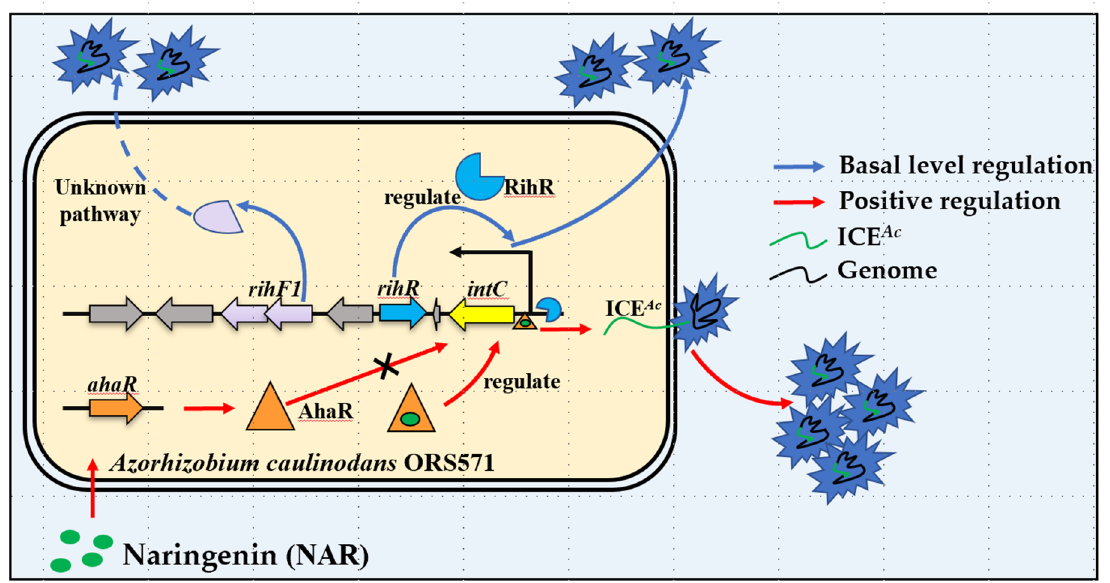
Figure 7. Model of ICE Ac transfer. Efficient transfer pathway: The host plant ( S. rostrata ) produces a flavonoid signal (NAR) that is recognized by AhaR. The AhaR protein is activated, then binds on the intC promoter to promote HGT frequency (~10 − 4 ). General transfer pathway: The RihR protein binds on the intC promoter and maintains the general level of HGT frequency (~10 − 7 ), and RihF1 maintains the same HGT frequency through an unknown process.